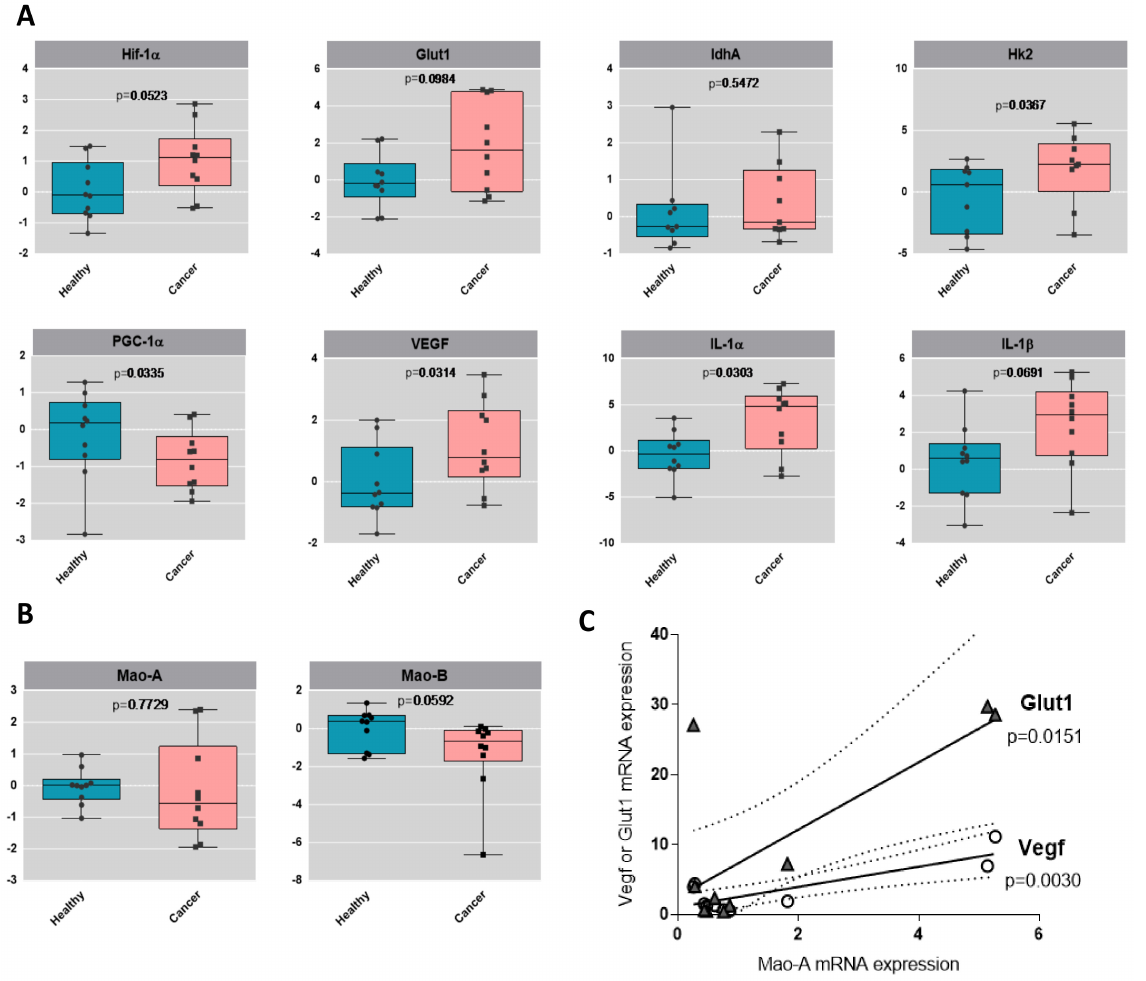
Figure 6. Glycolytic profile of human bladder tumors. ( A ) Boxplots of the gene expression by RT- qPCR analysis of HIF-1 α , GLUT1, LDHA, HK2, PGC-1 α , IL-1 α , IL-1 β and VEGF in healthy human samples and in cancer human samples, N = 9. Values are log2 transformed and p -values from t -test are displayed. ( B ) Boxplots of the gene expression by RT-qPCR analysis of MAO-A and MAO-B in healthy human samples and in cancer human samples, N = 9. Values are log2 transformed and p -values from t-test are displayed. ( C ) Correlation analysis between MAO-A expression and GLUT1 or VEGF expression levels in the different